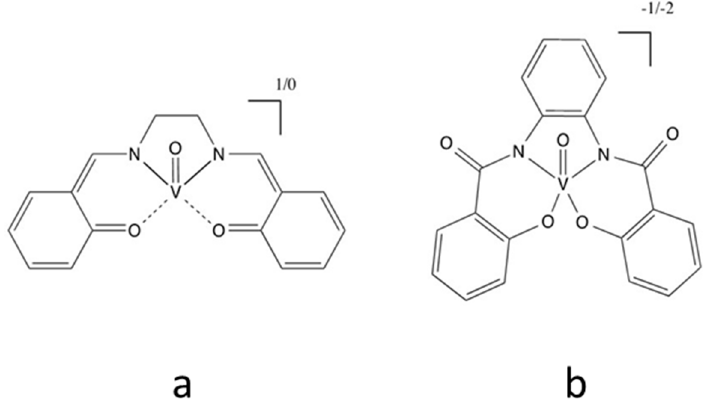
+/0 and ( b ) [VO(hybeb)] − 1/ − 2